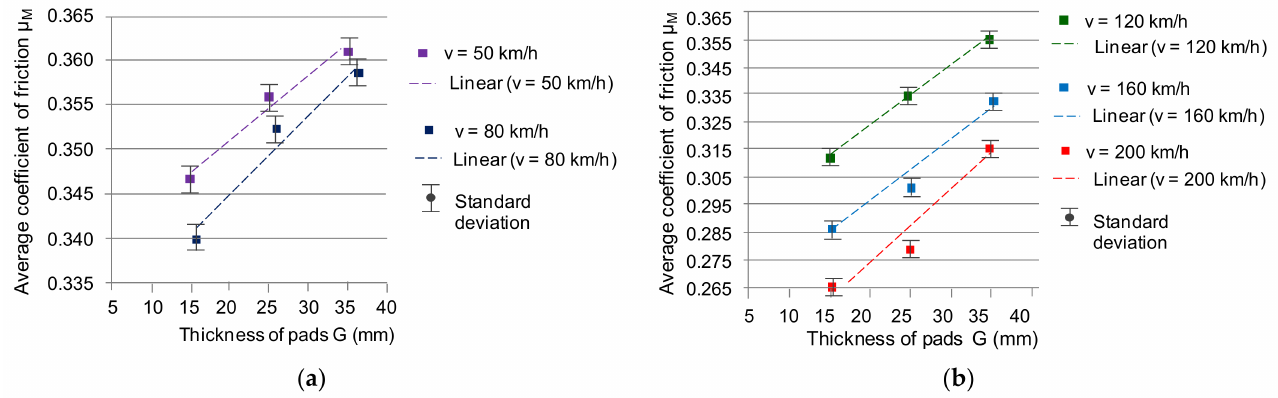
Figure 11. Dependence of the average coefficient of friction µ m on the thickness of the friction linings for the speed at the beginning of braking: ( a ) v = 50 and 80 km/h, ( b ) v = 120, 160 and 200